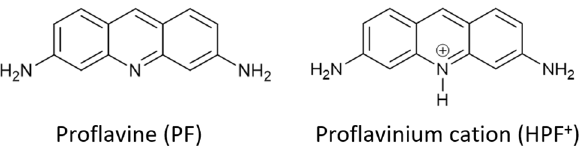
Figure 1. Neutral proflavine PF and monoprotonated proflavine, i.e. the proflavinium cation HPF + used in this